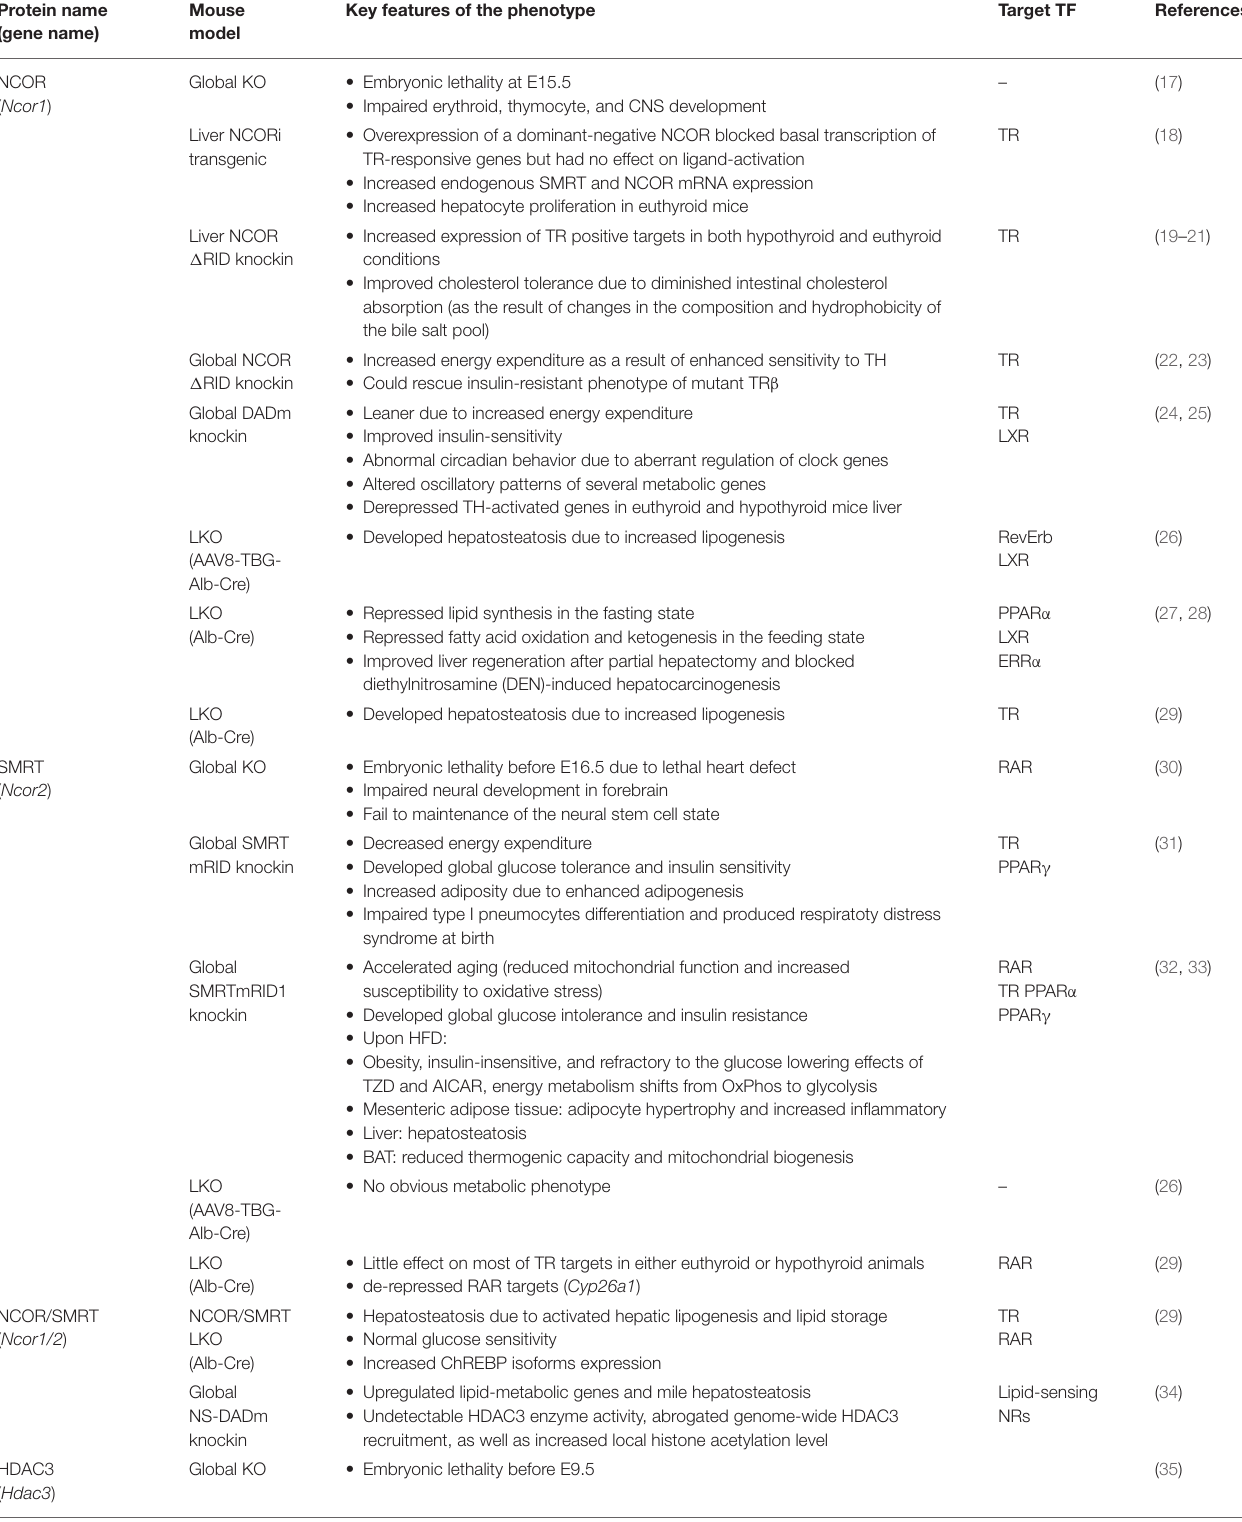
TABLE 1 | Summary of loss-of-function mouse models revealing liver-specific corepressor functions and target TFs. Protein name Mouse Key features of the (gene name) model